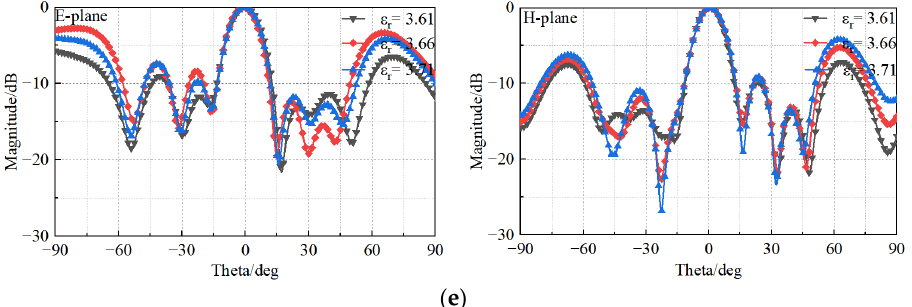
Figure 20. Simulated radiation patterns of the antenna in a high–low temperature chamber at ( a ) 12.5 GHz, ( b ) 13.5 GHz, ( c ) 14.5 GHz, ( d ) 15.5 GHz, and ( e ) 16.5 GHz.